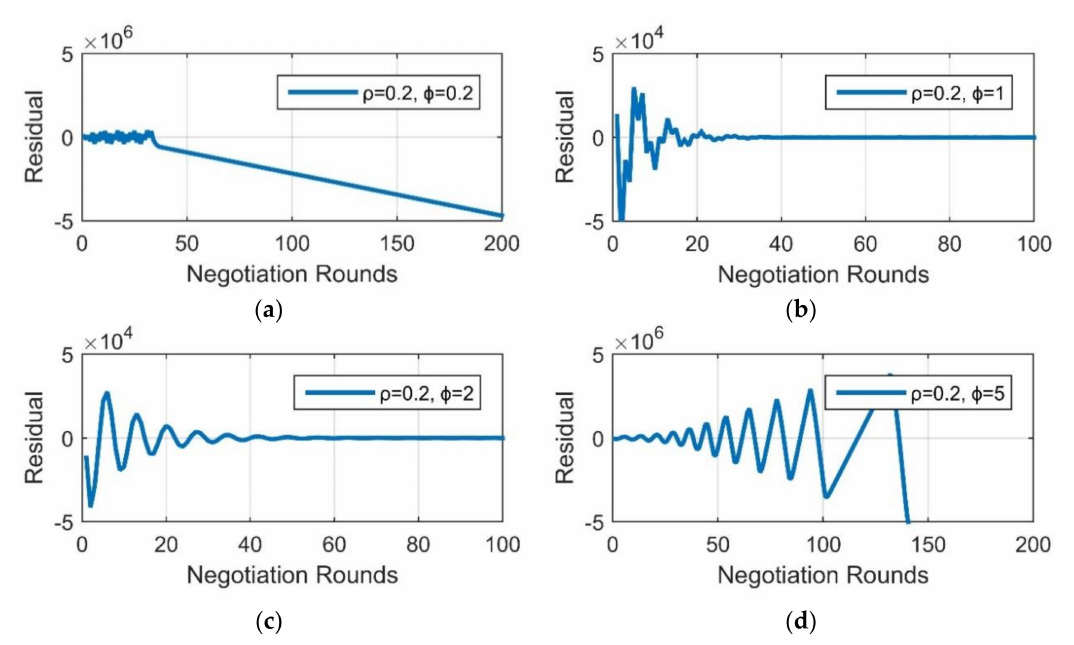
Figure 7. The negotiation process with di ff erent values of proximal factor φ . Adding proper proximal factor can increase the robustness of the negotiation. Sub-figure ( a ) shows adding a small Proximal Factor, φ = 0.2, does not help negotiation with a large penalty factor ρ = 0.2 to converge. Sub-figure ( b , c ) show that if the proximal factor, φ , is within proper range, the robustness of negotiation increases. ( d ) demonstrates an exceedingly large proximal factor, φ , breaks the negotiation